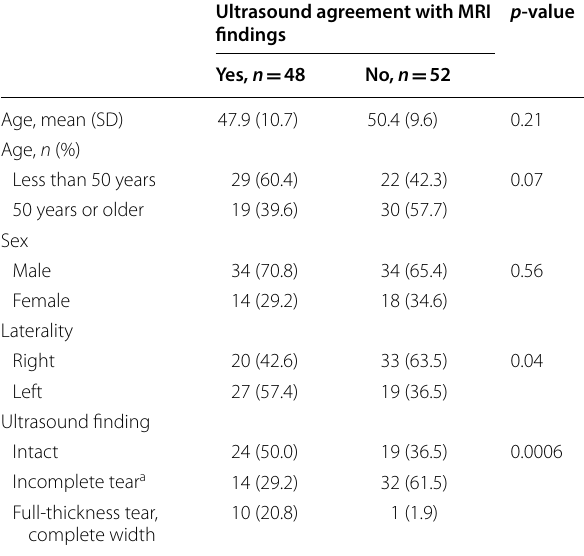
Table 2 Comparison of subjects with and